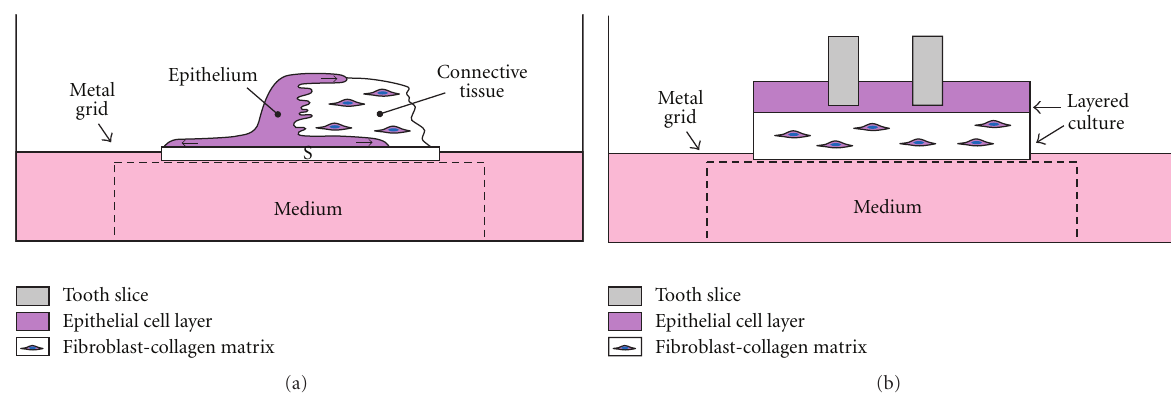
Figure 2: (a) A primary culture model for JE is formed when a piece of masticatory mucosa is placed on the top of a Millipore filter and cultured for 7–10 days. The interface between the filter and the epithelium shows morphologically similar hemidesmosomal attachment as the epithelium-tooth interface in vivo . Into this model planktonic bacteria or bacterial products can be added to the culture medium. (b) Organotypic culture model of the JE can be accomplished by culturing fibroblasts in a collagen gel and seeding keratinocytes and placing a piece of tooth on the top. Separately grown bacterial biofilms can be added onto the cultures. Cocultures with bacterial biofilms can be used to study host-microbe interactions with this model.